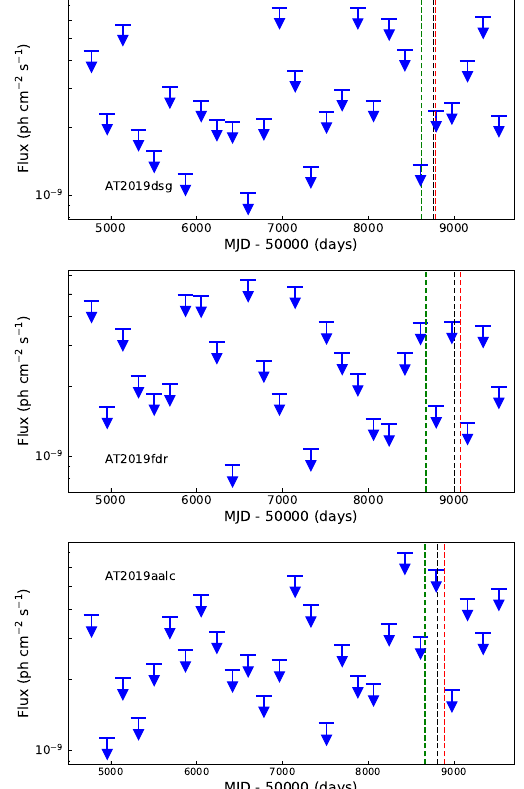
Figure 1. Fermi -LAT lightcurves for AT2019dsg ( upper panel ), AT2019fdr ( middle panel ) and AT2019aalc ( lower panel ). The upper limits are derived in the 0.1–100 GeV energy range for the sources during the full time interval, with evenly spaced binning of six months. The green, red and black dashed vertical lines mark the peak time of the ZTF lightcurve, the peak time of WISE lightcurve and the arrival time of associated neutrinos,